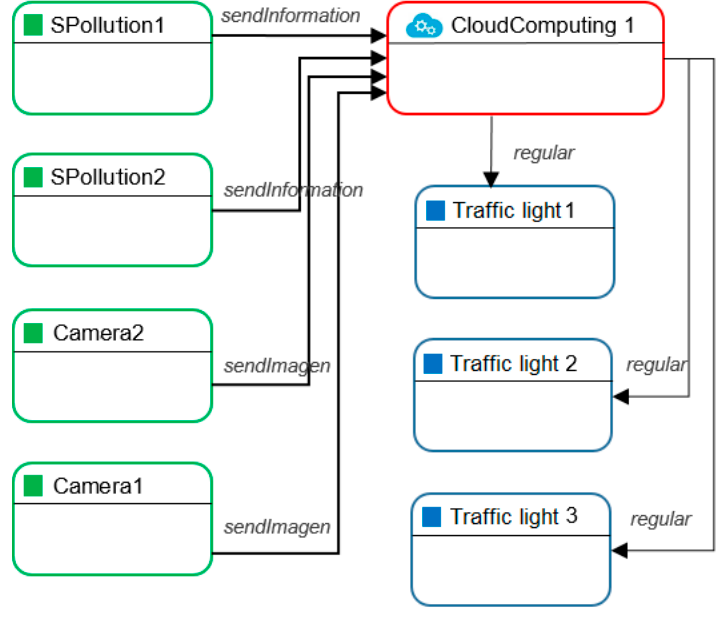
Figure 4. Fragment of the system